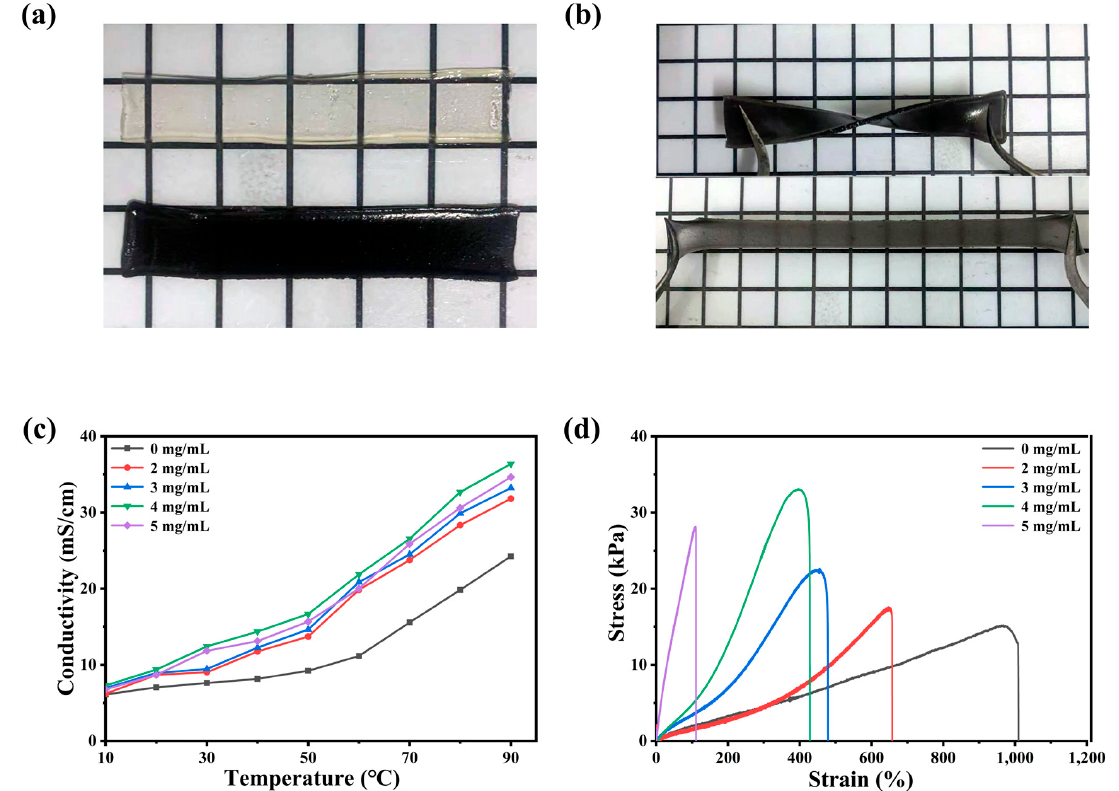
Figure 1. Electron photograph of ionogel. ( a ) PAIM-X ionogel and PAI ionogel; ( b ) twisted and strained PAIM-X hydrogel; ( c ) the conductivity of the different MXene content of PAIM ionogels as a function of temperature; ( d ) stress–strain curves of PAIM-X ionogel with different MXene content.